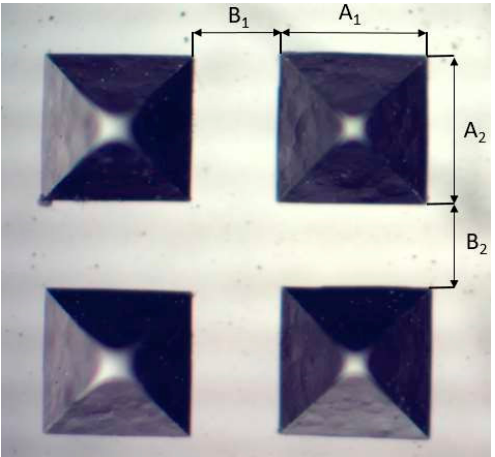
Figure 1. The microscopic photo of the glass microprisms with determined geometric dimensions (A 1 , A 2 , B 1 , B 2 ).